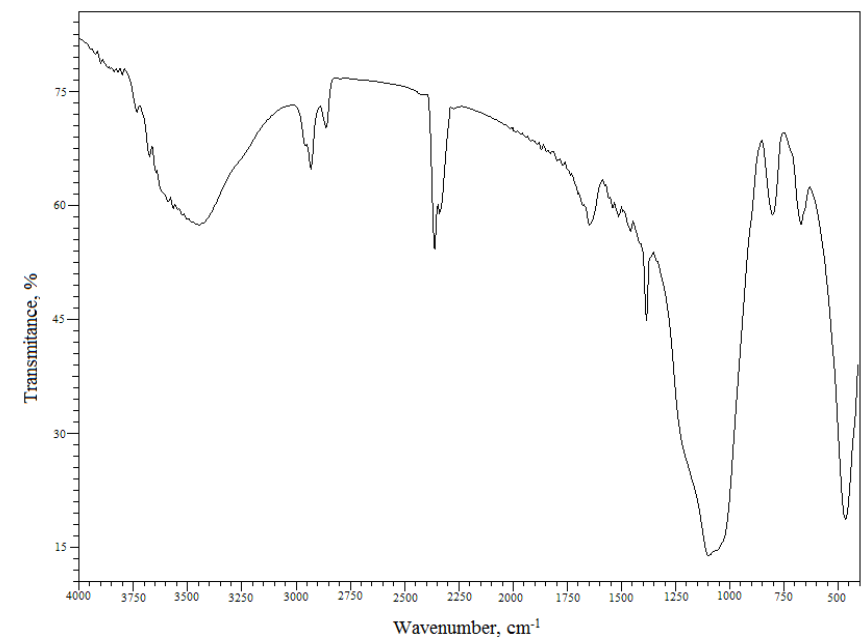
Figure 3. FTIR spectrum of the studied material.